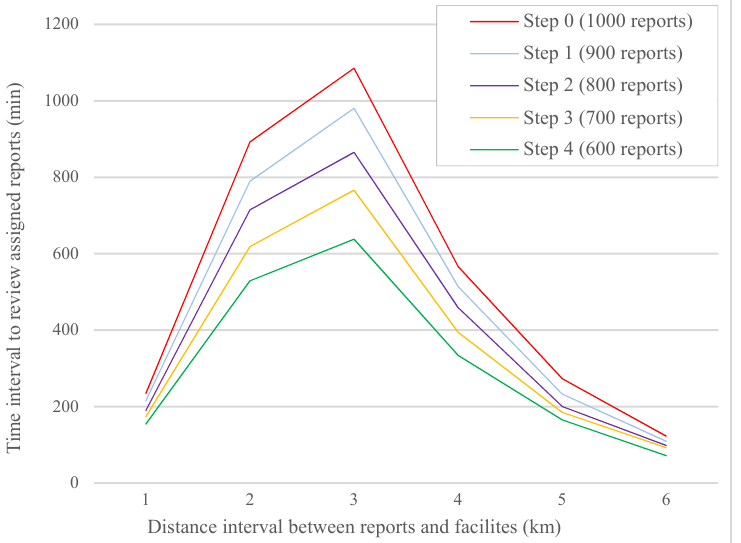
Figure 5. Time interval for facilities to review assigned reports in distance intervals between facilities and reports.